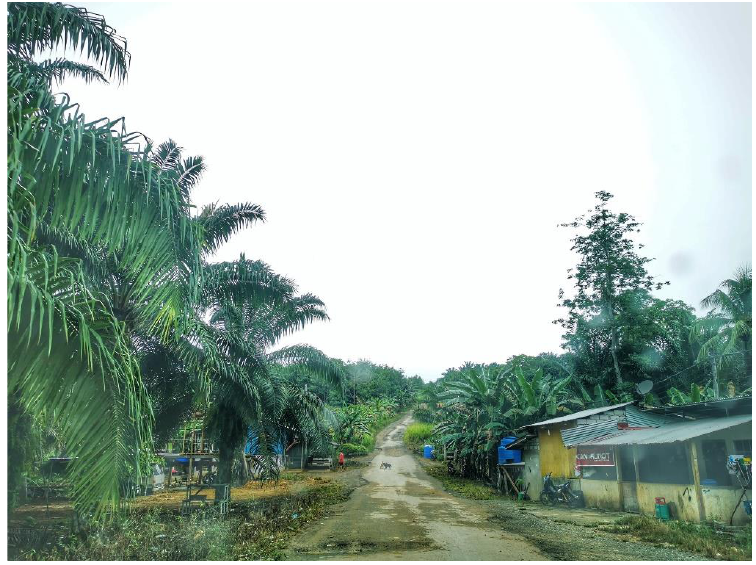
Figure 7. Commercial oil palm plantation (left), with coconut and banana trees at the village.